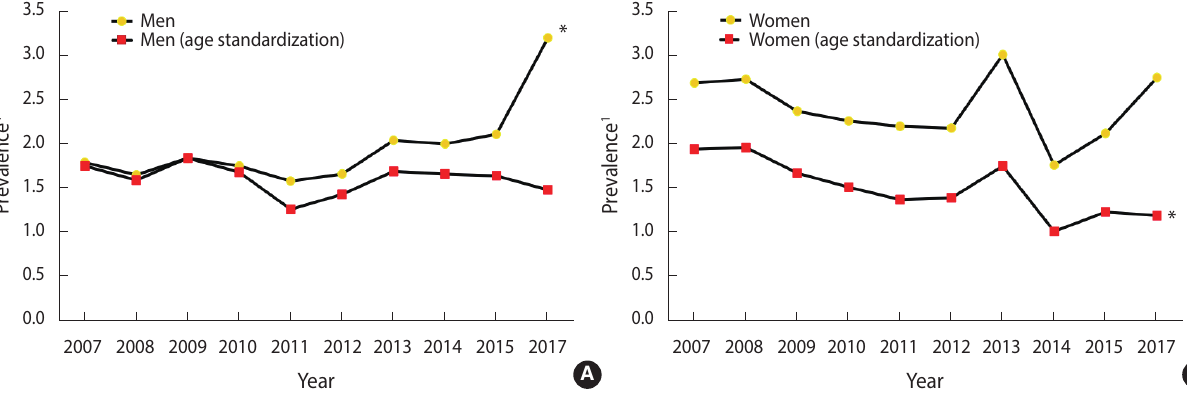
Figure 2. Trend analysis of edentulism in Korea National Health and Nutrition Examination Survey by gender (A: men, B: women). 1 Prev- alence of 2017 was calculated from 2016-2018 data; crude prevalence means real magnitude of edentulism at the time of the survey. *p<0.05 for trend test.